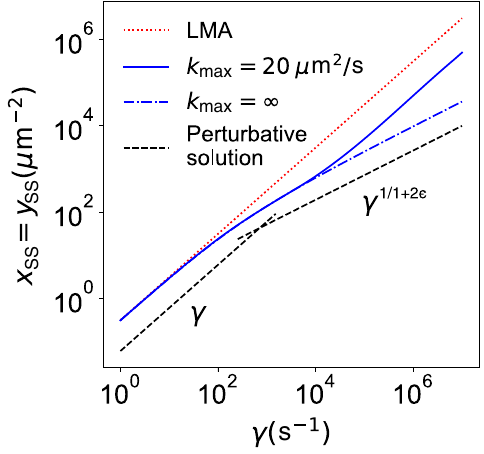
FIG. 10. The steady-state concentration of the oscillatory state is given by Eq. (C18) when γ ¼ α . The LMA steady state increases linearly with γ (red dotted line), but the LCDR steady state increases sublinearly except for γ ≈ 0 (blue solid line) for ¼ 20 μ m 2 = s and k ¼ ∞ . For k ¼ ∞ , such that both k max max max κ ð Φ Þ is always κ þ κ Φ ϵ , the LCDR steady-state solution is 0 1 correctly given by the perturbation theory (black dashed line), which predicts that x and y scale as γ , when Φ ; i.e., x is SS SS SS small and they scale as γ 1 = 1 þ 2 ϵ when Φ > Φ 0 ¼ 1 × 10 5 .